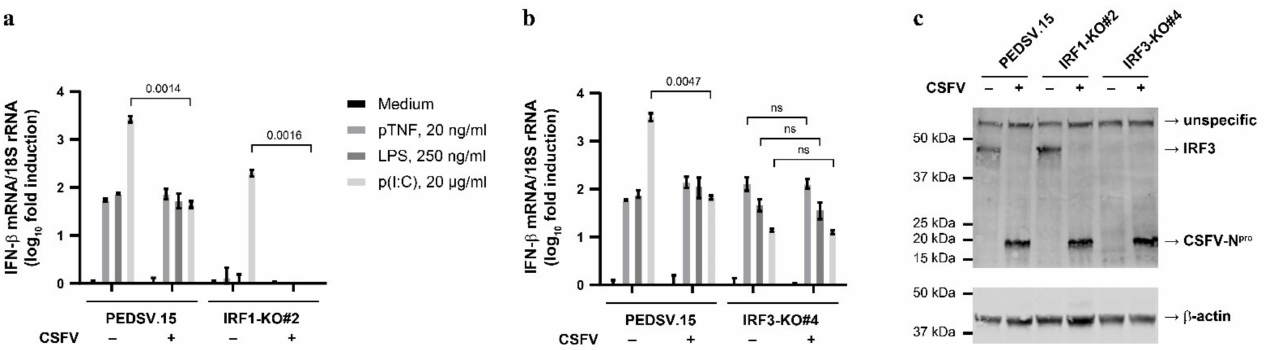
Figure 6. CSFV infection does not interfere with TNF- or LPS-mediated induction of IFN- β mRNA in PEDSV.15 cells. The PEDSV.15 ( a , b ), IRF1-KO#2 ( a ) and IRF3-KO#4 cells ( b ) were mock-infected (–) or infected with CSFV vEy-37 (+) for 3 days and stimulated subsequently for 2.5 h with pTNF, LPS or p(I:C) at the indicated concentrations or left untreated (medium). After stimulation, IFN- β mRNA induction normalized with 18S RNA was quantified by RT-qPCR. ( c ) Parallel cultures of the mock- (–) or CSFV-infected (+) PEDSV.15, IRF1-KO#2 and IRF3-KO#4 cells were lysed and the proteins were separated by SDS–PAGE and analyzed by means of Western blotting for IRF3, CSFV N pro and β -actin expression. The data in ( a , b ) show the means and the standard deviations of three independent experimental replicas. Statistically significant differences were determined with the unpaired, two-tailed Student’s t -test (the p -values are indicated; ns,